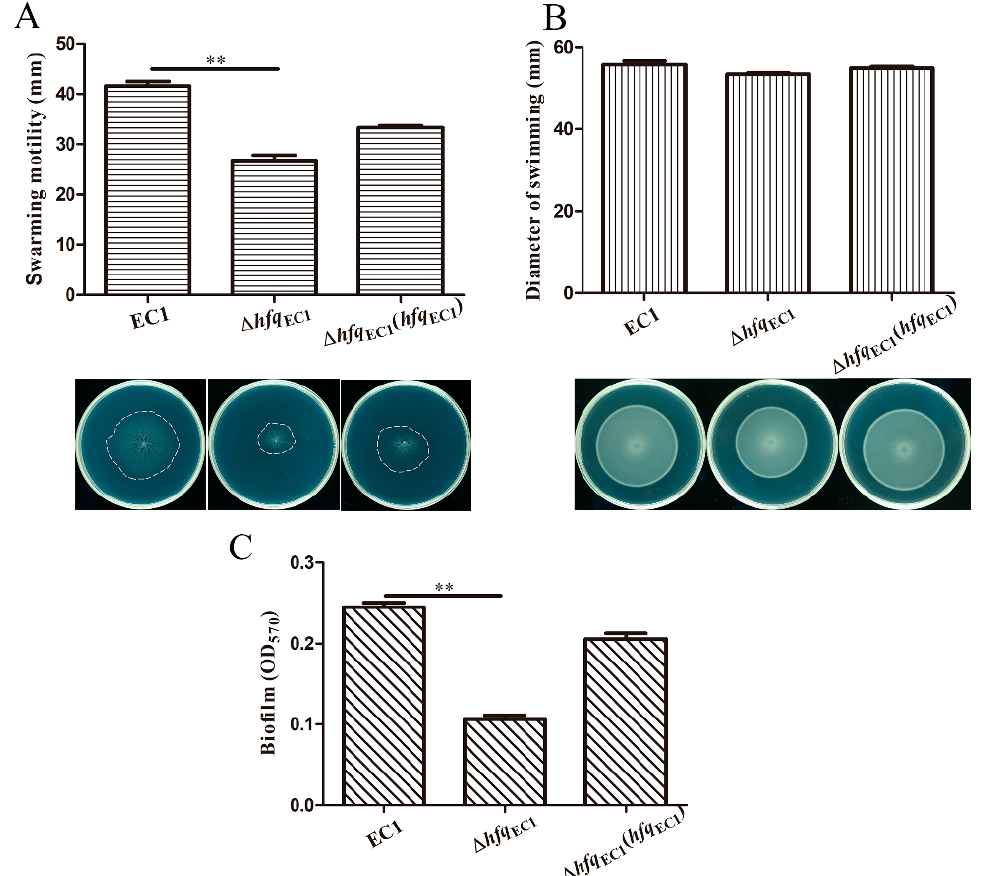
Figure 3. Disruption of hfq EC1 decreases bacterial swarming motility and biofilm formation. ( A ) Swarming motility of Dickeya oryzae EC1 and its derivatives. The diameters were measured after incubation at 28 °C for 18 h. ( B ) Swimming motility of D. oryzae EC1 and its derivatives. The plates were incubated at 28 °C for 24 h before photography. ( C ) Biofilm formation of D. oryzae EC1 and its derivatives. Bacterial strains were grown in super optimal broth plus glycerol (SOBG) medium at 28 °C with shaking for 18 h. Experiments were individually performed at least three times in triplicate. The data shown are the means ± SE ( n = 3). ** p < 0.05.